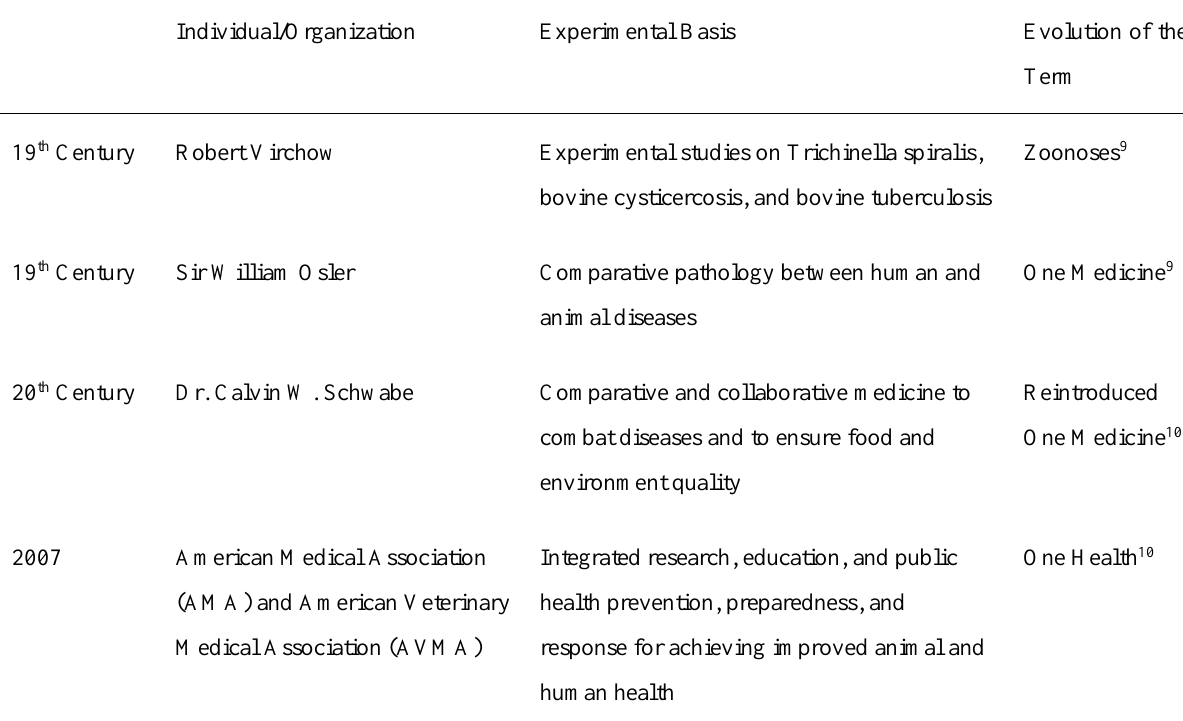
Table 1: Evolution of the term One Health